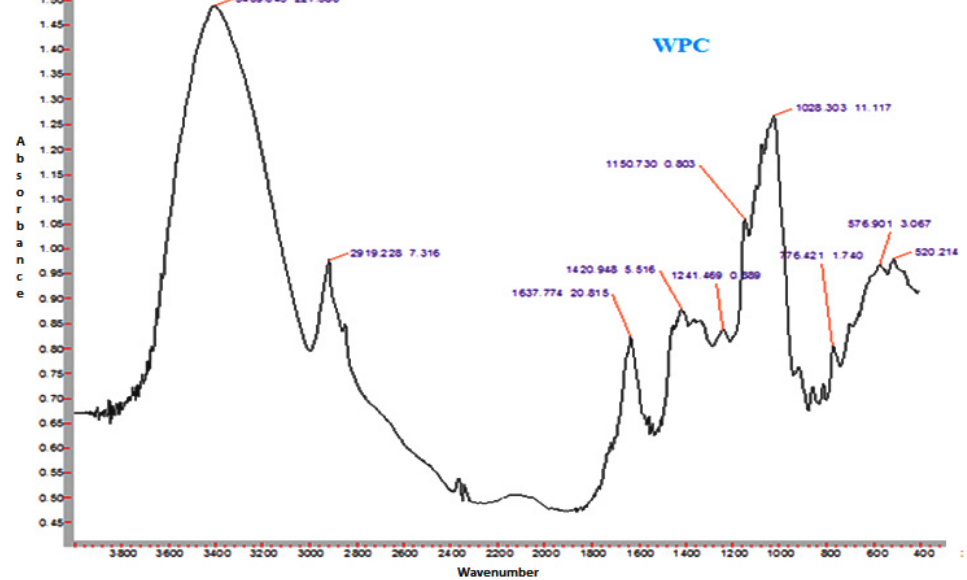
Figure 6. Representative FTIR spectrum of spray-dried nutritionally rich honey powder fortified Figure 6 with whey protein concentrate